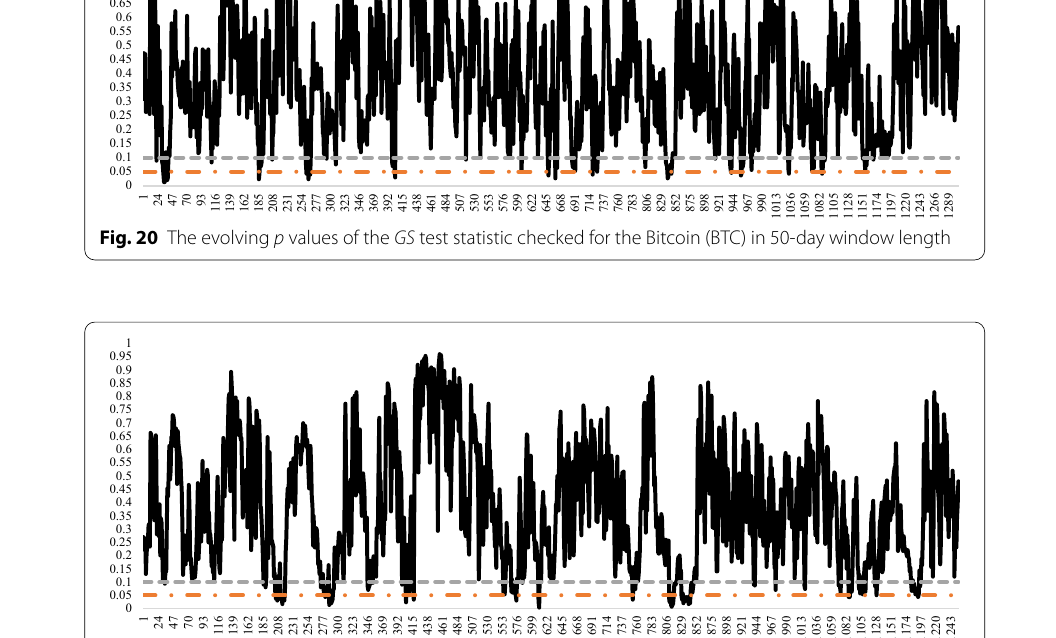
Fig. 21 The evolving p values of the GS test statistic checked for the Bitcoin (BTC) in 100-day window length